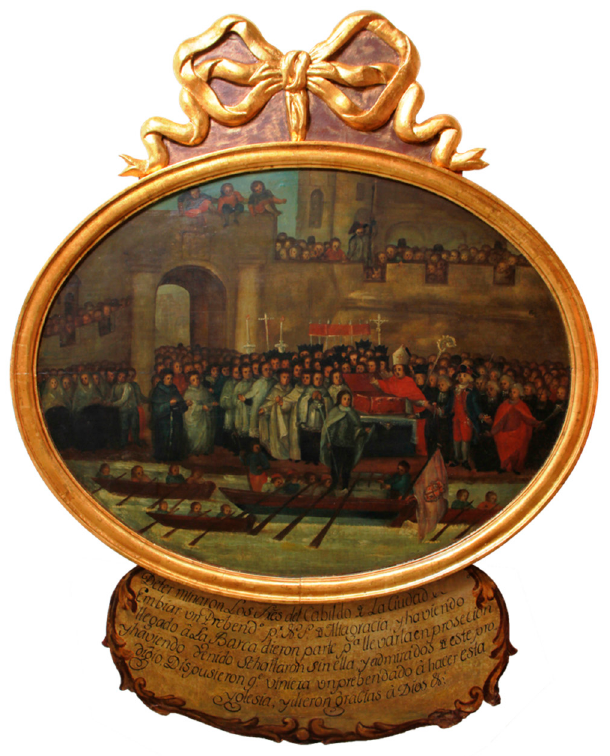
Figure 5. Empty chest , Altagracia medallion, oil on panel, c. 1760–1778, Museo de Altagracia, Higüey. Used with permission from Museo de Altagracia.